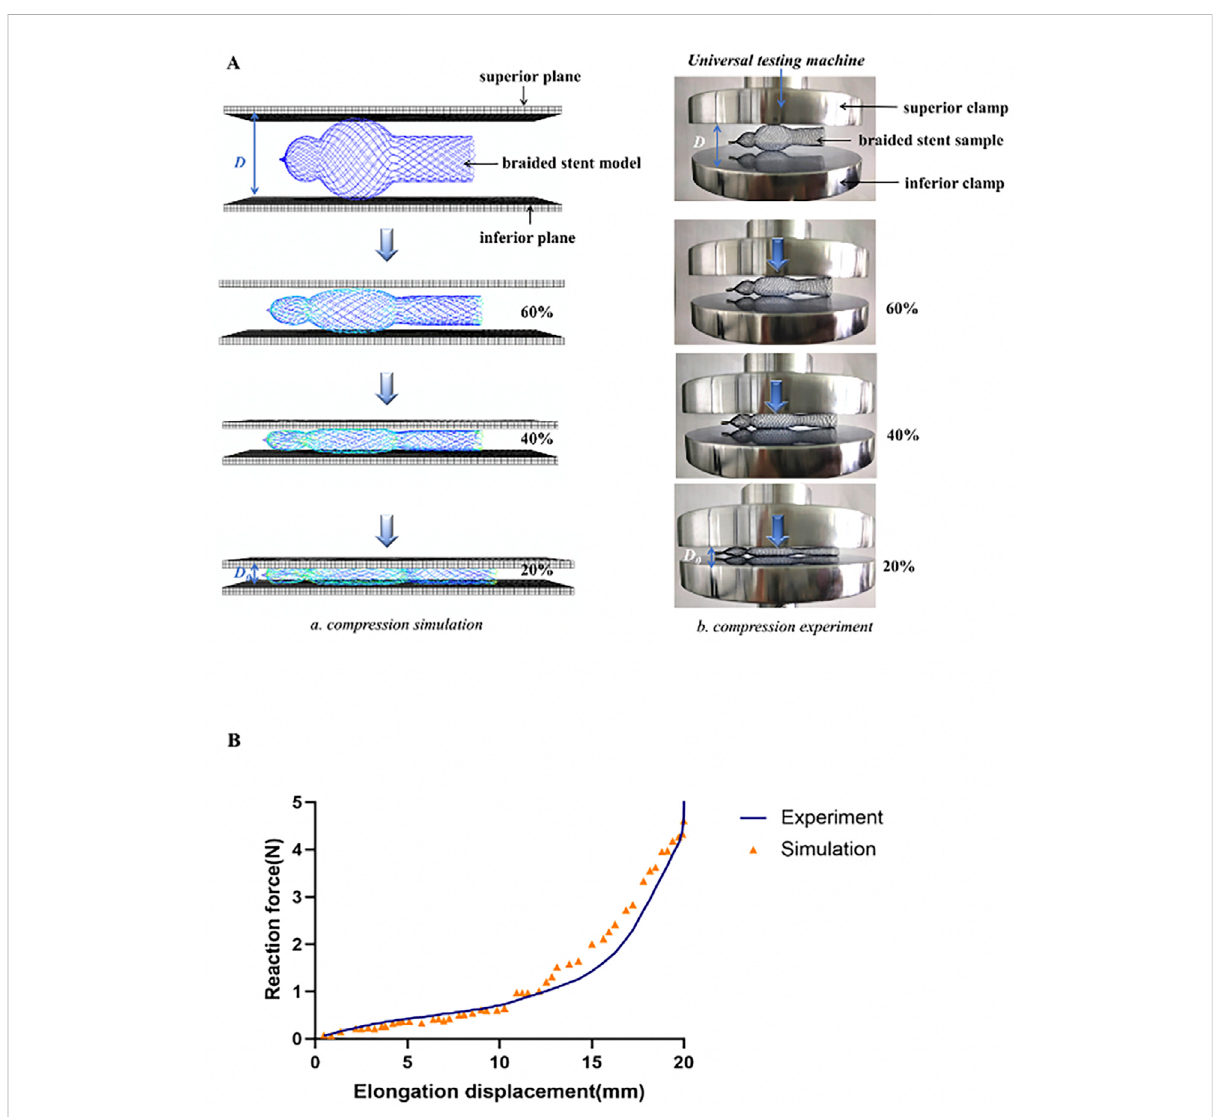
FIGURE 4 Experimental veri fi cation. (A) Comparation of compressive processes betweennumerical simulation and experiment(a) Finite element analysis fortestingthecompressivebehaviorofthestents(b)Con fi gurationusedfortestingthecompressivebehaviorofthestents. (B) Comparisonofforce- displacement curve of compression simulation with